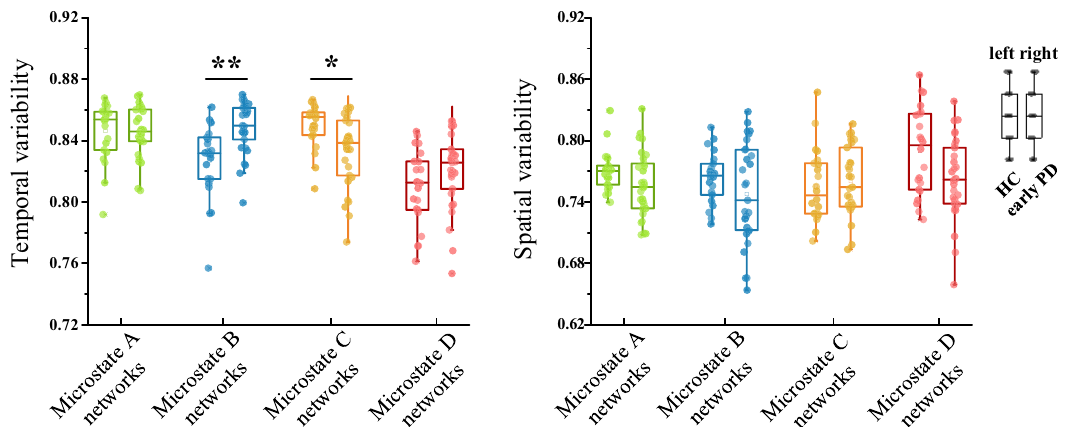
Fig. 4 The temporal and spatial variability of whole brain microstate functional connectivity networks in patients with early PD and healthy controls, respectively. The green, blue, yellow, and red boxes represent functional connectivity networks of microstate class A – D, respectively. The box plot on the left of each pair represents healthy controls and the box plot on the right represents patients with early PD. * indicates a statistical difference with p < 0.05 and ** indicates a statistical difference with p < 0.01. FDR correction has been performed for p - values. Each dot re p resents every single subject. The horizontal line within the box indicates the median, box limits represent the upper and lower quartiles, and the whiskers indicate the range of values within 1.5 times the interquartile range. Table 2. Descriptive statistics of temporal variability of whole brain microstate functional connectivity networks in patients with early PD and healthy controls.